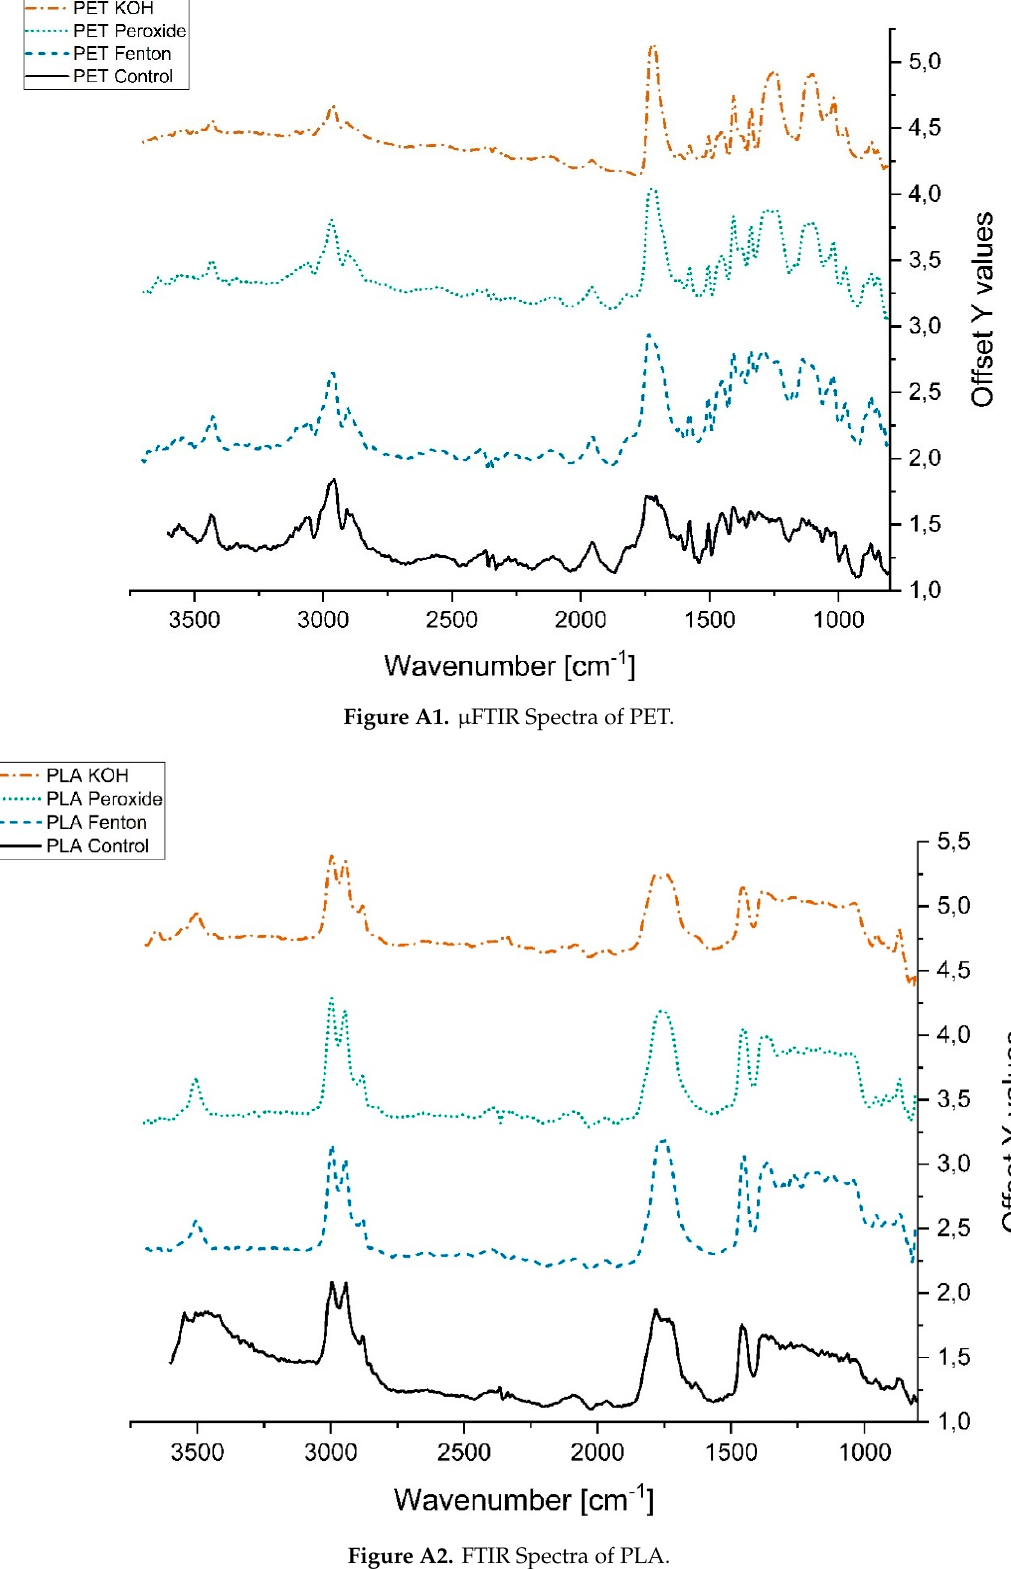
Figure A2. FTIR Spectra of PLA.